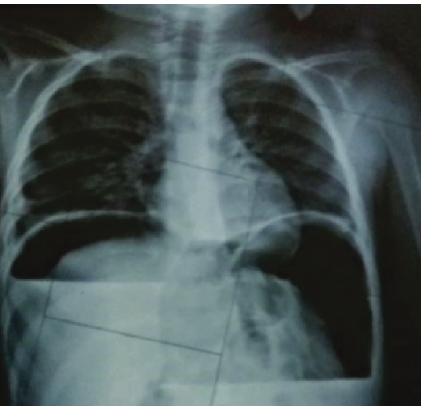
Figure 1: Showing gas under diaphragm.